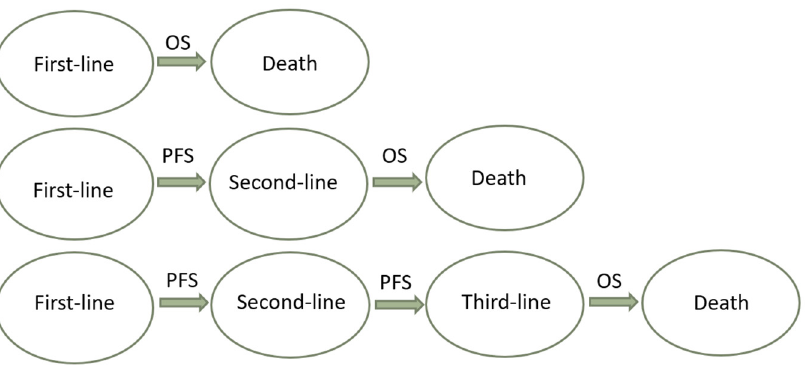
Figure 2. Evaluation of the benefit of sequential therapies: overall survival is the result of the sum of progression-free survival of different subsequent lines of therapy.